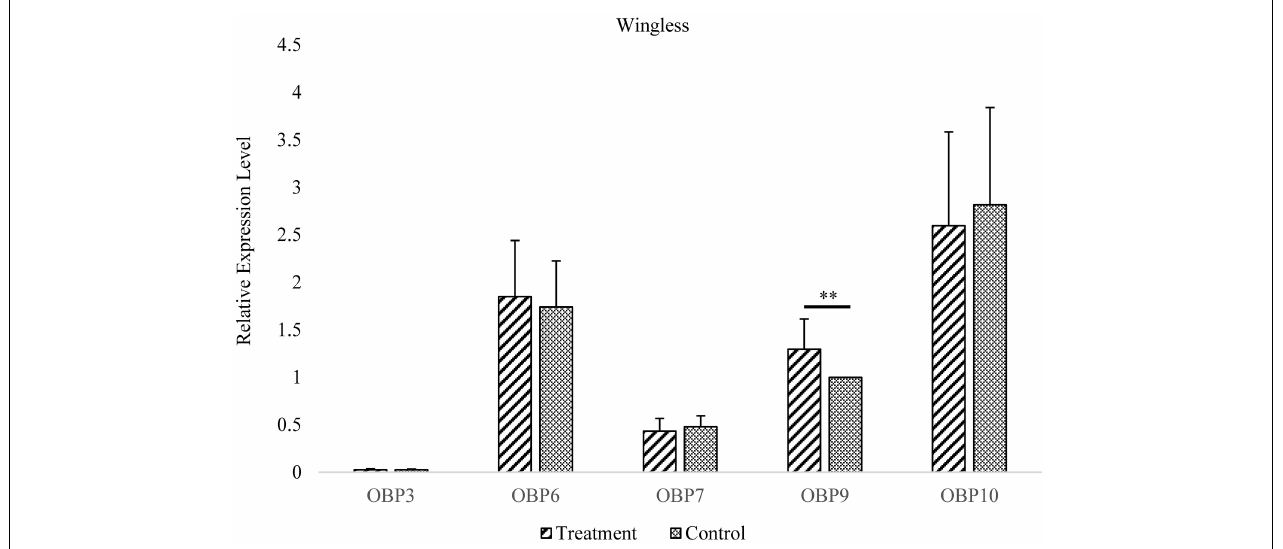
FIGURE 4 | Antennal OBP3/6/7/9/10 expression in the wingless morph before and after EBF induction. Fold changes are relative to the antennal transcript levels of OBP9 in the wingless morph before EBF induction. **Significant difference at the P = 0.01 level (two-sample t -test). Wingless, antennae of wingless aphid; Treatment, EBF induction; Control, blank